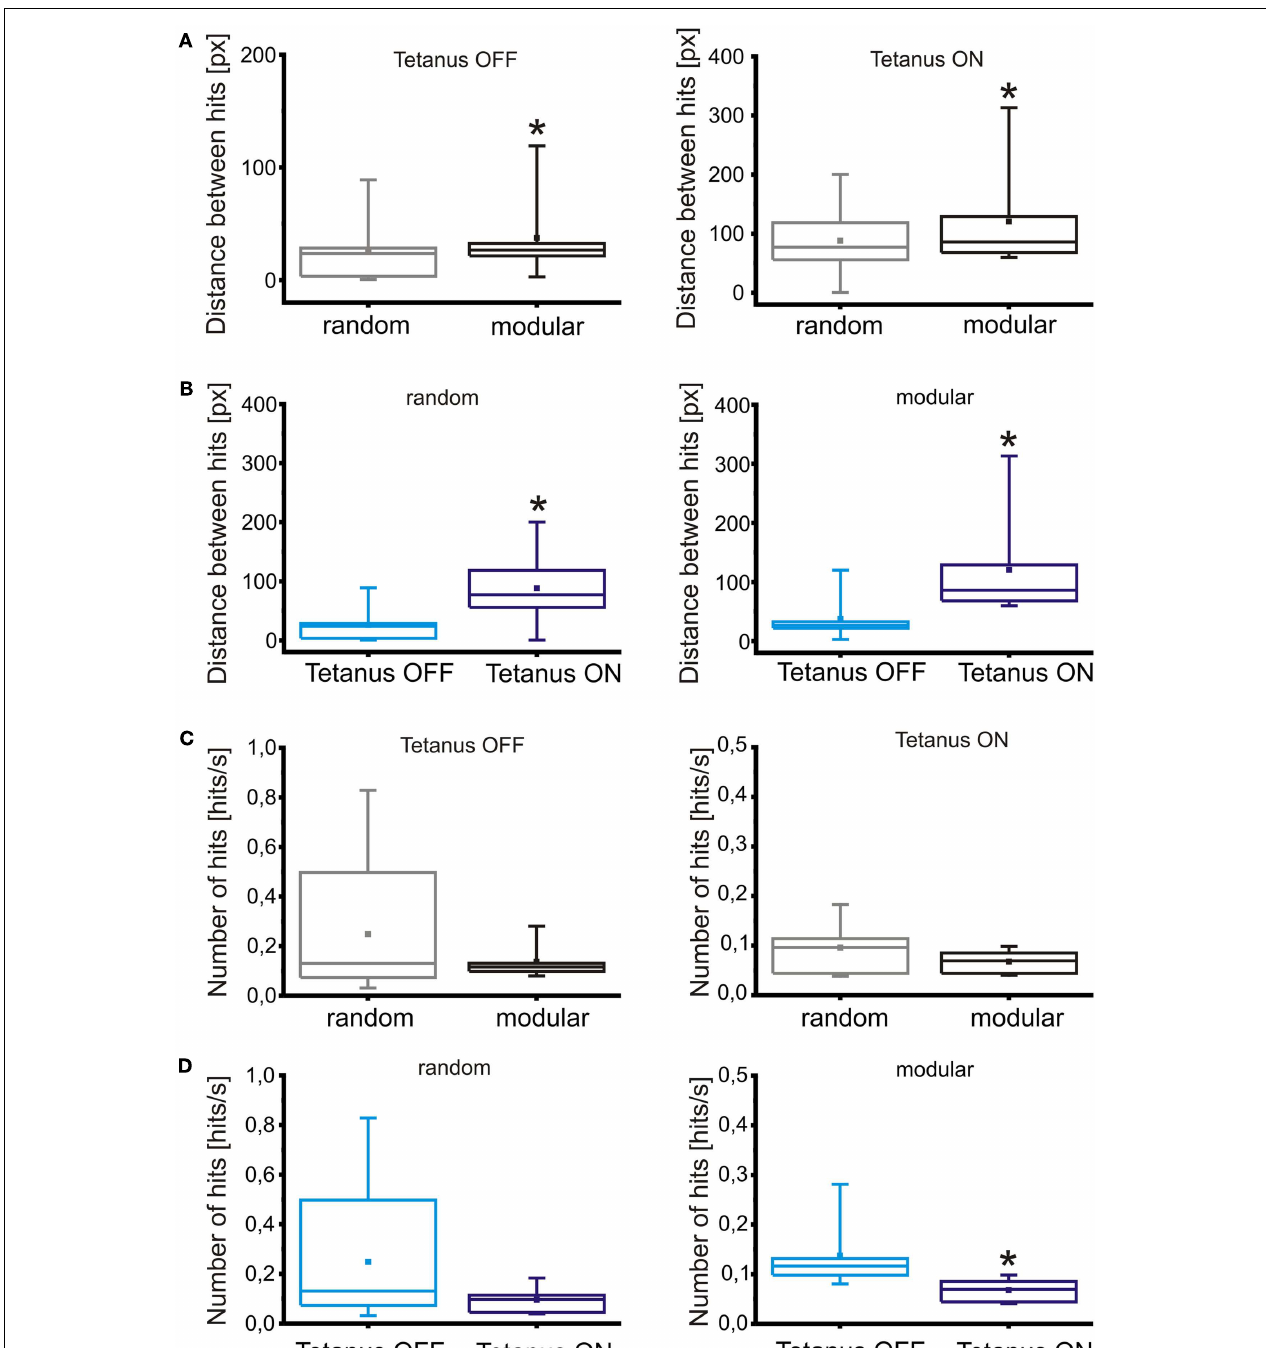
evaluated in terms of average number of hits per second. (D) Comparison of robot performances in different conditions of tetanic stimulation, in random (left graph) and modular networks (right graph), evaluated in hits per second. All the values are obtained in the experiments described in text ( N = 11 experiments for the random condition, N = 6 for the modular), with a tetanic stimulation session following each standard robot run. Box range: percentile 25–75; box whiskers: percentile 5–95; line: median; square: mean. Statistical analysis was carried out by using Mann–Whitney test for not-normal data, significance level = * p <